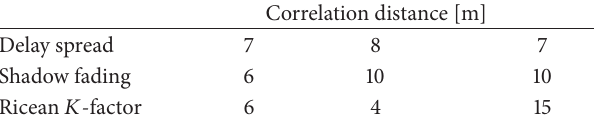
Table 6: Correlation distance in [45–47].